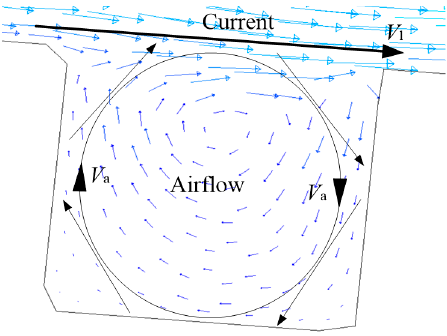
Figure 12. Schematic diagram of vortex cushion effect.